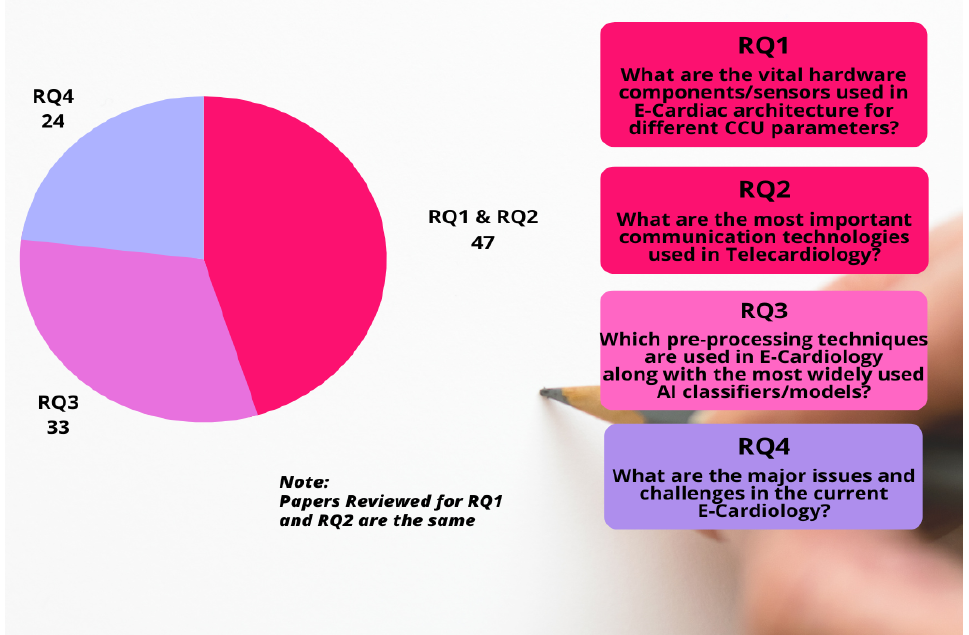
Figure 5. Statistical analysis of reviewed papers in terms of formulated